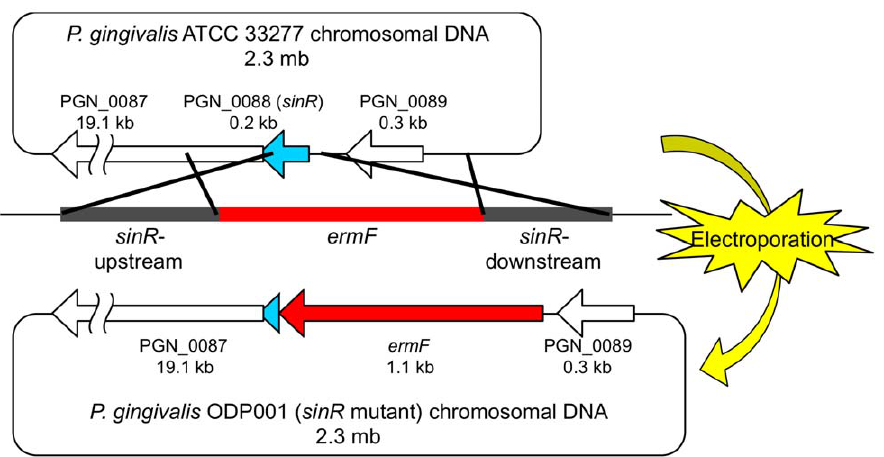
Figure 5. Scheme of construction of the sinR mutants. To yield strain ODP001 ( sinR mutant; D sinR::ermF ), the linearized DNA fragment including ermF (red) was introduced into chromosomal DNA of P. gingivalis ATCC 33277 by electroporation.